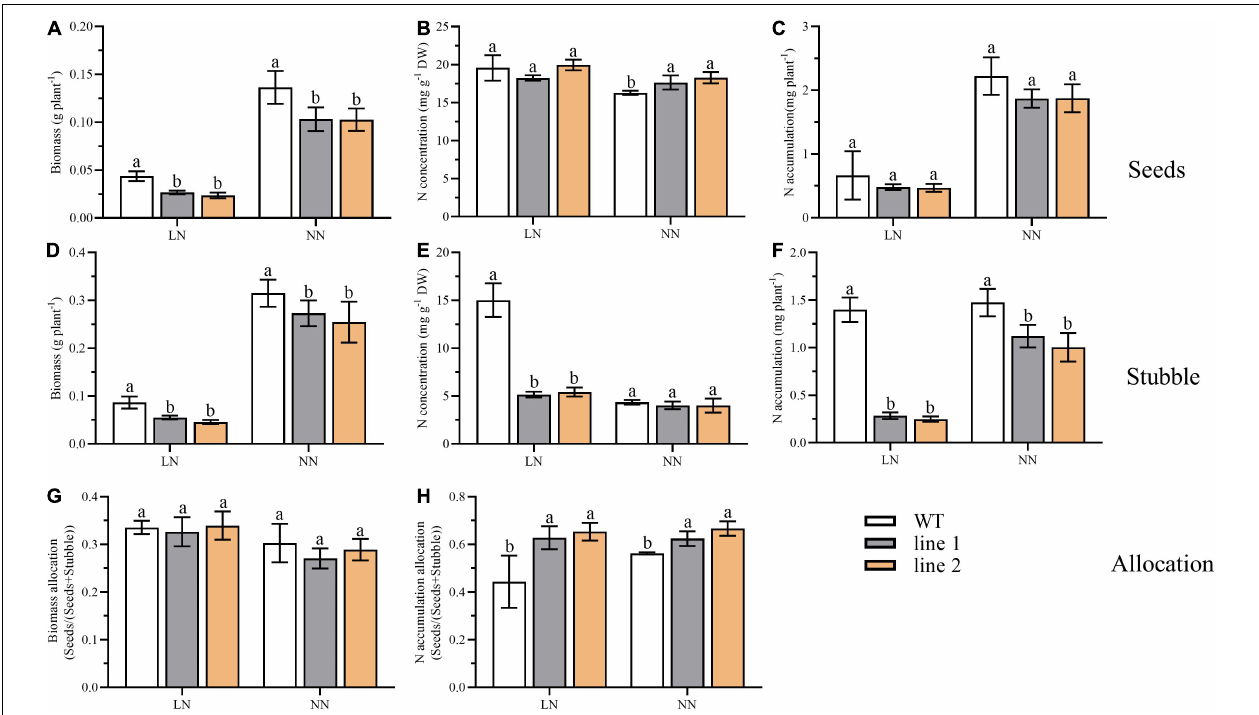
FIGURE 8 | Biomass, N accumulation and allocation in soil at reproductive phase of two transgenic Arabidopsis lines and wild type. Biomass (A) , N concentration (B) and N accumulation (C) of desiccated seeds ( n ≥ 5). Biomass (D) , N concentration (E) and N accumulation (F) of desiccated stubble ( n ≥ 5). (G) The biomass allocation in seeds (seeds biomass/biomass of seeds and stubble) ( n ≥ 5). (H) The N allocation in seeds (seeds N accumulation/N accumulation of seeds and stubble) ( n ≥ 5). Three biological replicates were performed. Data are means ± SD . Significant differences are indicated by letters (ANOVA; P ≤ 0.05). WT, wild type (Col-0), line 1 and line 2, two transgenic lines. LN, low nitrogen, 0.25 mM N (0.125 mM NH 4 NO 3 ); NN, normal nitrogen, 5 mM N (2.5 mM NH 4 NO 3